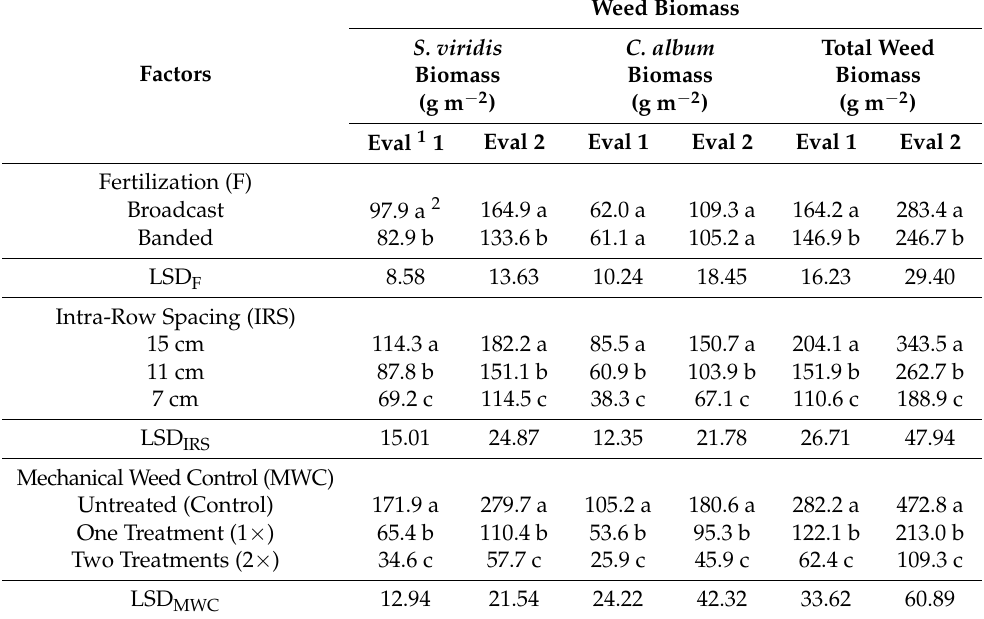
Table 3. Setaria viridis (L.) P.Beauv. and Chenopodium album L. biomass (g m − 2 ) data obtained for each experimental factor. Total weed biomass data (g m − 2 ) are also included. Means were separated according to Fischer’s Least Significance Difference (LSD) test ( a =